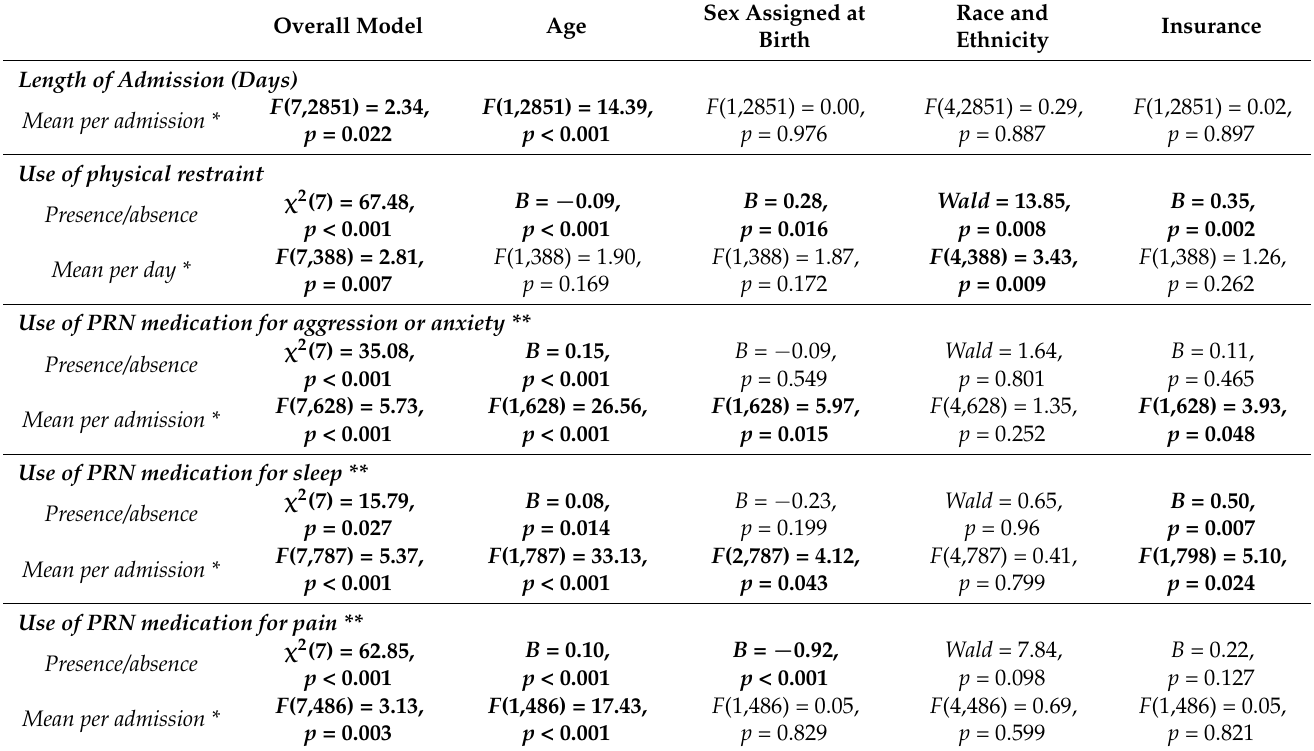
Table 5. Models evaluating demographic factors and clinical outcomes for patients without ASD/DD. Overall Model Age